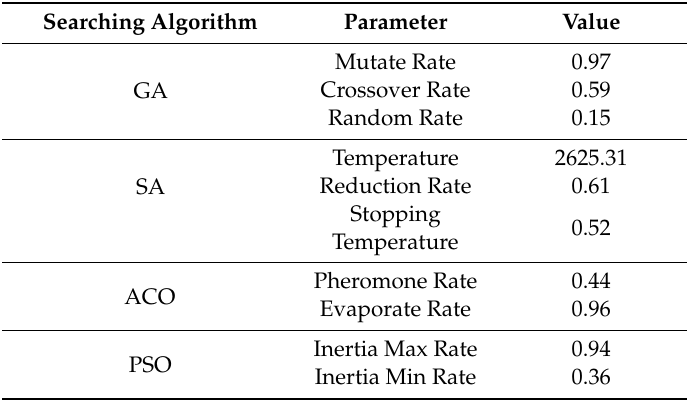
Table 9. Tuned value of the